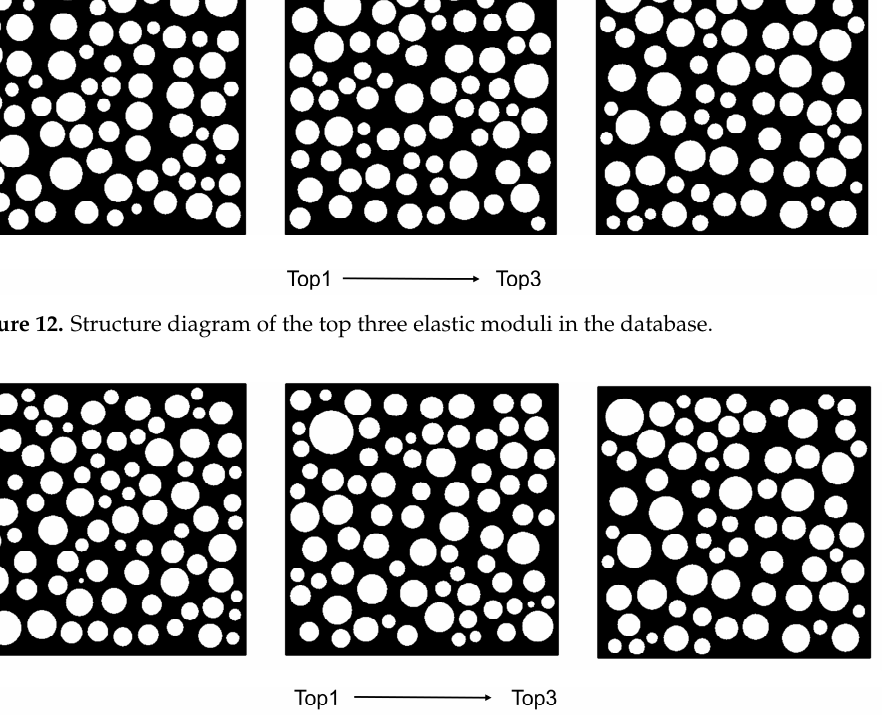
Figure 13. Structure diagram of the top three plateau stress in the database.